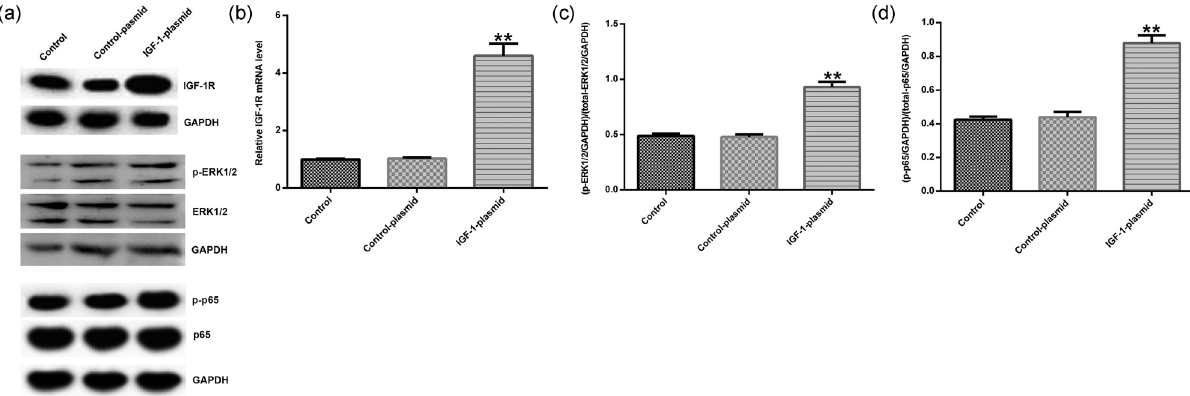
Figure 5: The e ff ect of IGF - 1 on MAKP and NF - κ B signaling pathways in HVFs from POP patients. Control plasmid and IGF - 1 plasmid were transfected into HVFs and then Western blotting assay was used to detect the protein level of IGF - 1R, p - ERK1/2, ERK1/2, p - p65, and p65; and qRT - PCR was used to measure the mRNA level of IGF - 1R. ( a ) The e ff ect of IGF - 1 siRNA on IGF - 1R, p - ERK1/2, ERK1/2, p - p65, and p65 protein expression in HVFs. ( b ) The e ff ect of IGF - 1 siRNA on IGF - 1R mRNA expression in HVFs. ( c and d ) The e ff ect of IGF - 1 siRNA on p - ERK1/ 2/ERK1/2 and p - p65/p65 ratio. Data were reported as mean ± SD. ** p < 0.01 vs control